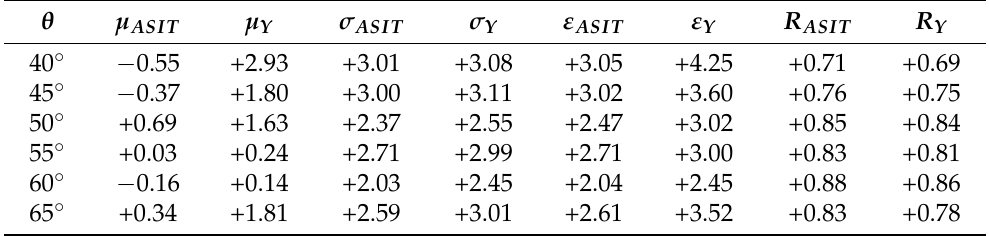
Figure 8. The GMF residual distribution at six incidence angles: 40 ◦ ( a ), 45 ◦ ( b ), 50 ◦ ( c ), 55 ◦ ( d ), 60 ◦ ( e ) and 65 ◦ ( f ), for the ASIT GMF (solid line) and KaDPMod GMF from Yurovsky et al. (dashed line). Table 2. The mean bias ( µ dB) and the mean standard deviation ( σ dB) of the residuals of both the ASIT GMF and the KaDPMod from Yurovsky et al. along with the root mean square difference ( ε dB) and the correlation coefficient ( R